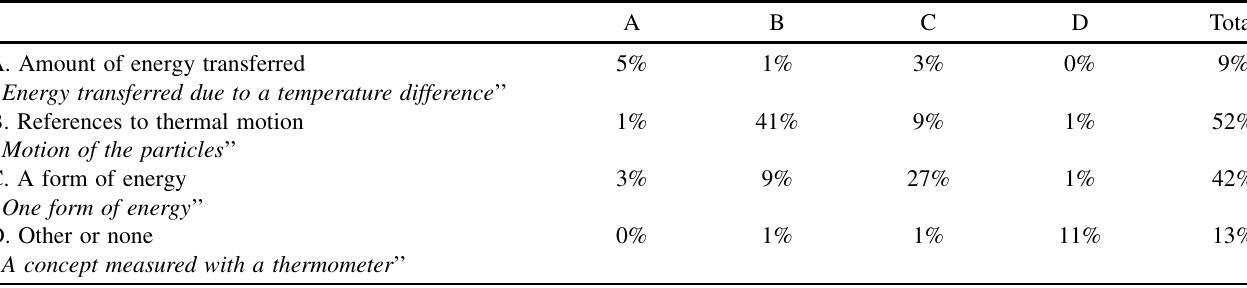
TABLE III. Categorization of students’ conceptions of heat. Categories A–D refer to the same categories in rows and columns. N ¼ 75 . A typical example from each category is presented after the category symbol and title in italics.